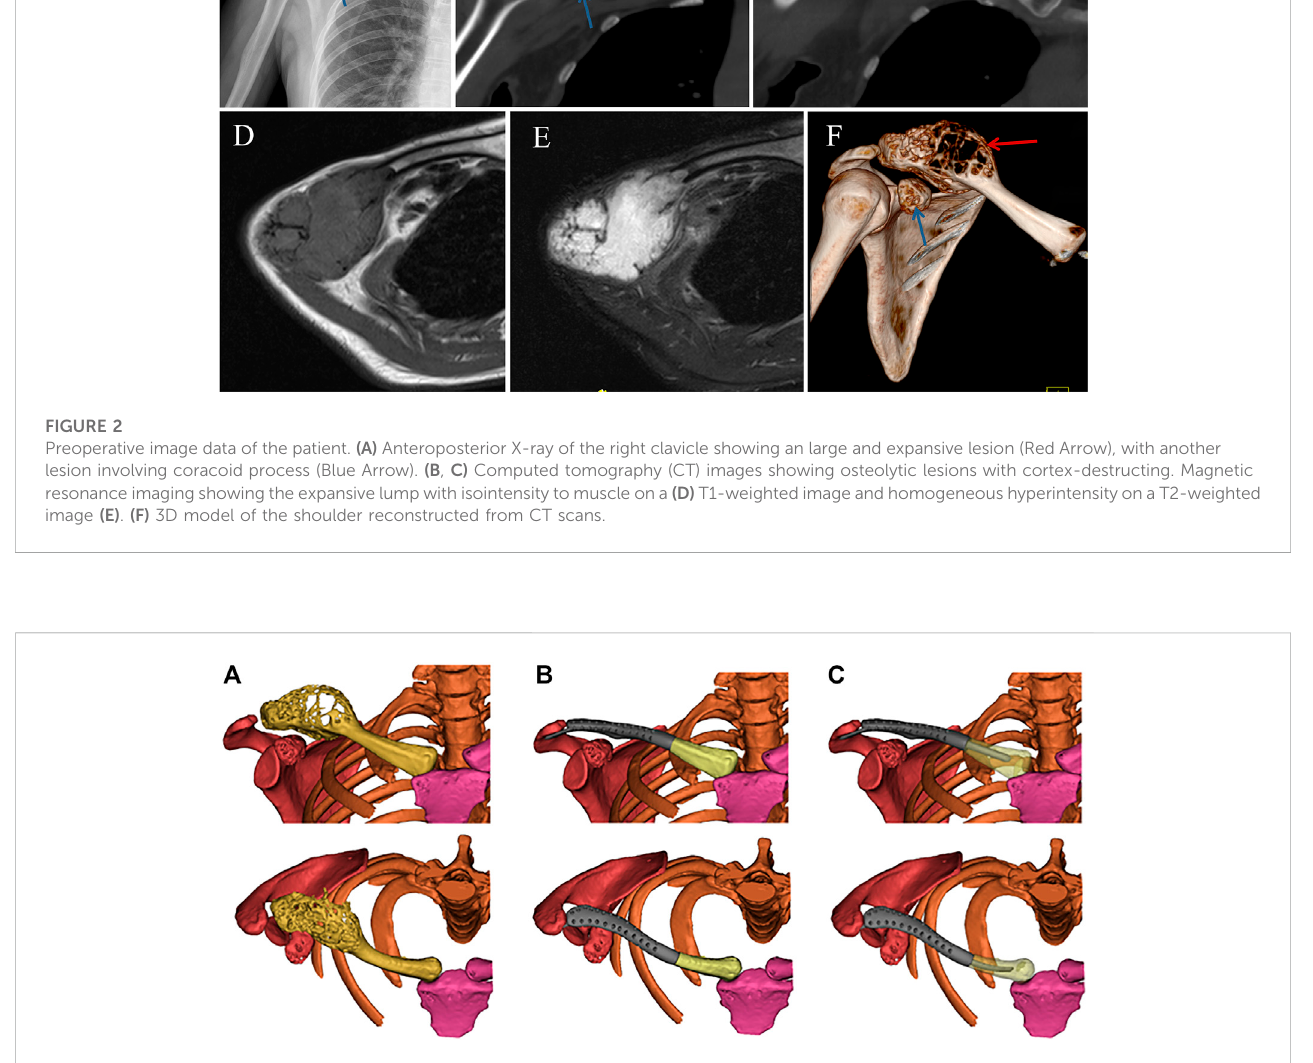
FIGURE 3 (A) Reconstructed virtual 3D tumors and clavicle models. (B) The virtual 3D personalized prosthesis model. (C) Simulated implantation of the prosthesis with a curved intramedullary